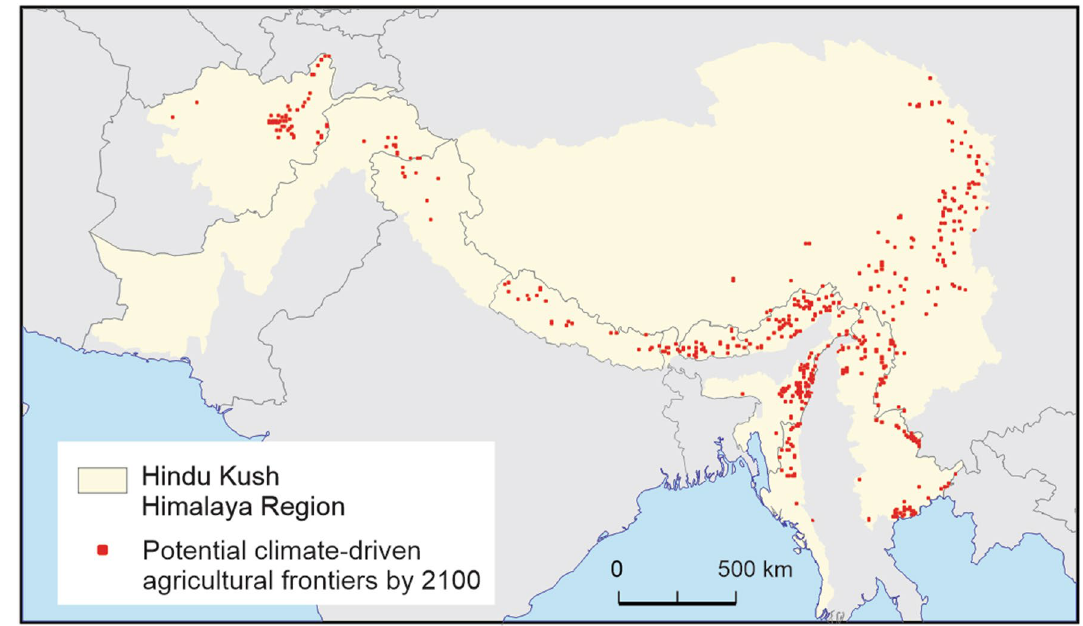
Fig. 1 Hindu Kush Himalaya region showing the potential climate driven frontier by 2100 (Adapted from Hannah et al. [9], KC et al. [19], KC et al.